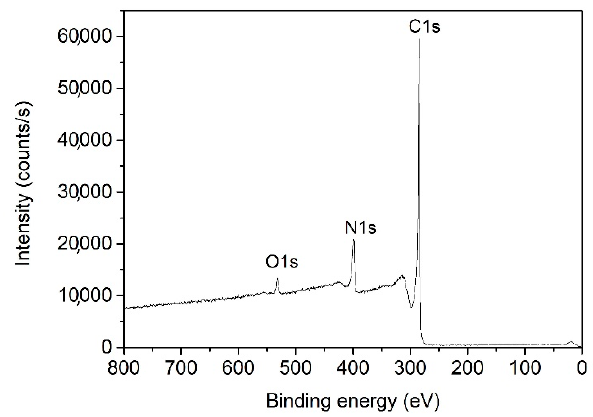
Figure 5. X-ray photoelectron spectroscopy (XPS) survey spectrum of N-doped carbon nanomesh sample with deposition time of 105